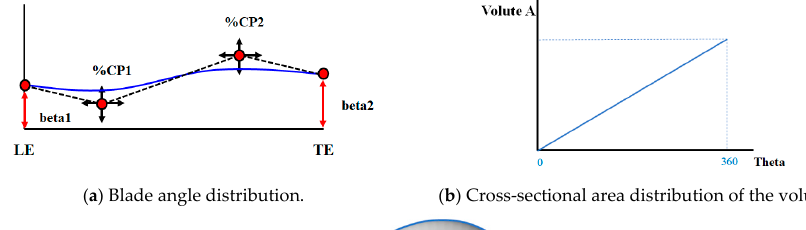
Figure 7. Definition of the design variables.